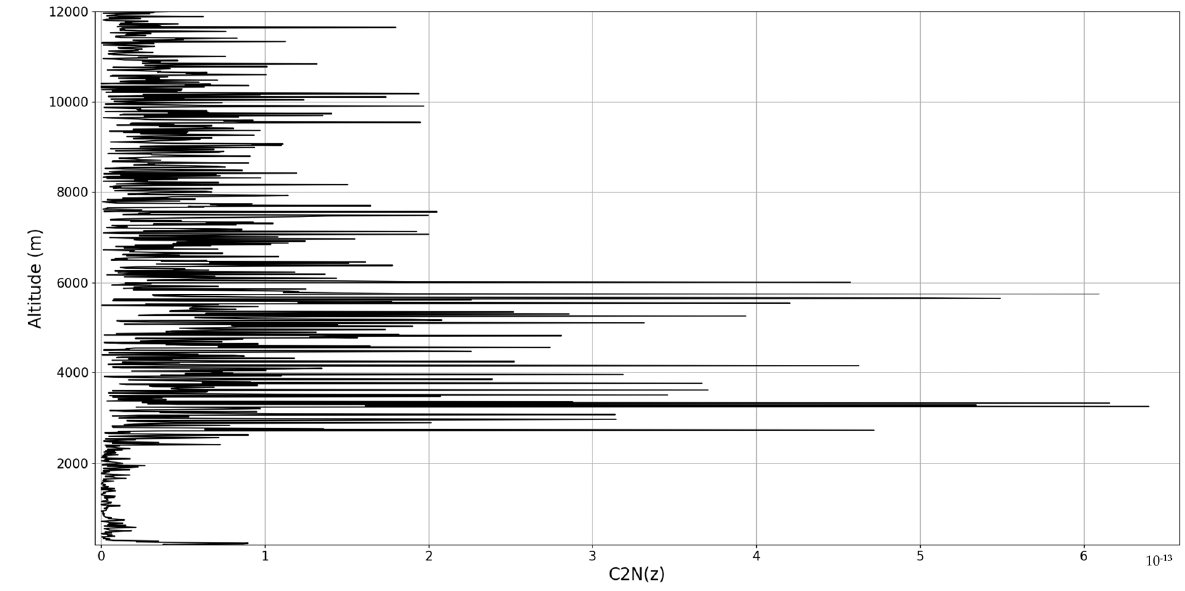
Figure 13. C (cid:2898)(cid:2870) profile, λ = 1064 nm , Gala ț i, Romania, 22 December 2021. Figure 13. C 2 profile, λ = 1064 nm, Galat N